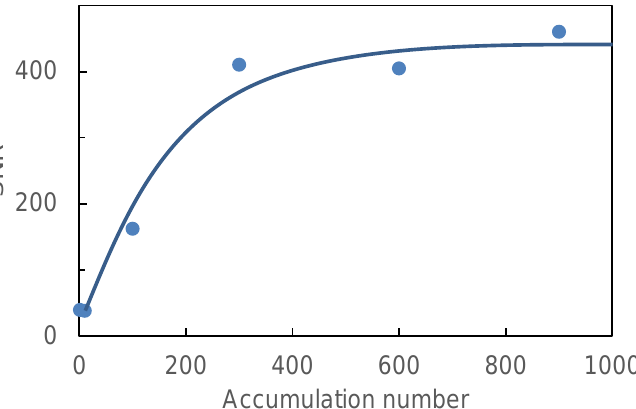
Figure 5. Correlation between signal-to-noise ratio (SNR) of obtained spectra and accumulation number.